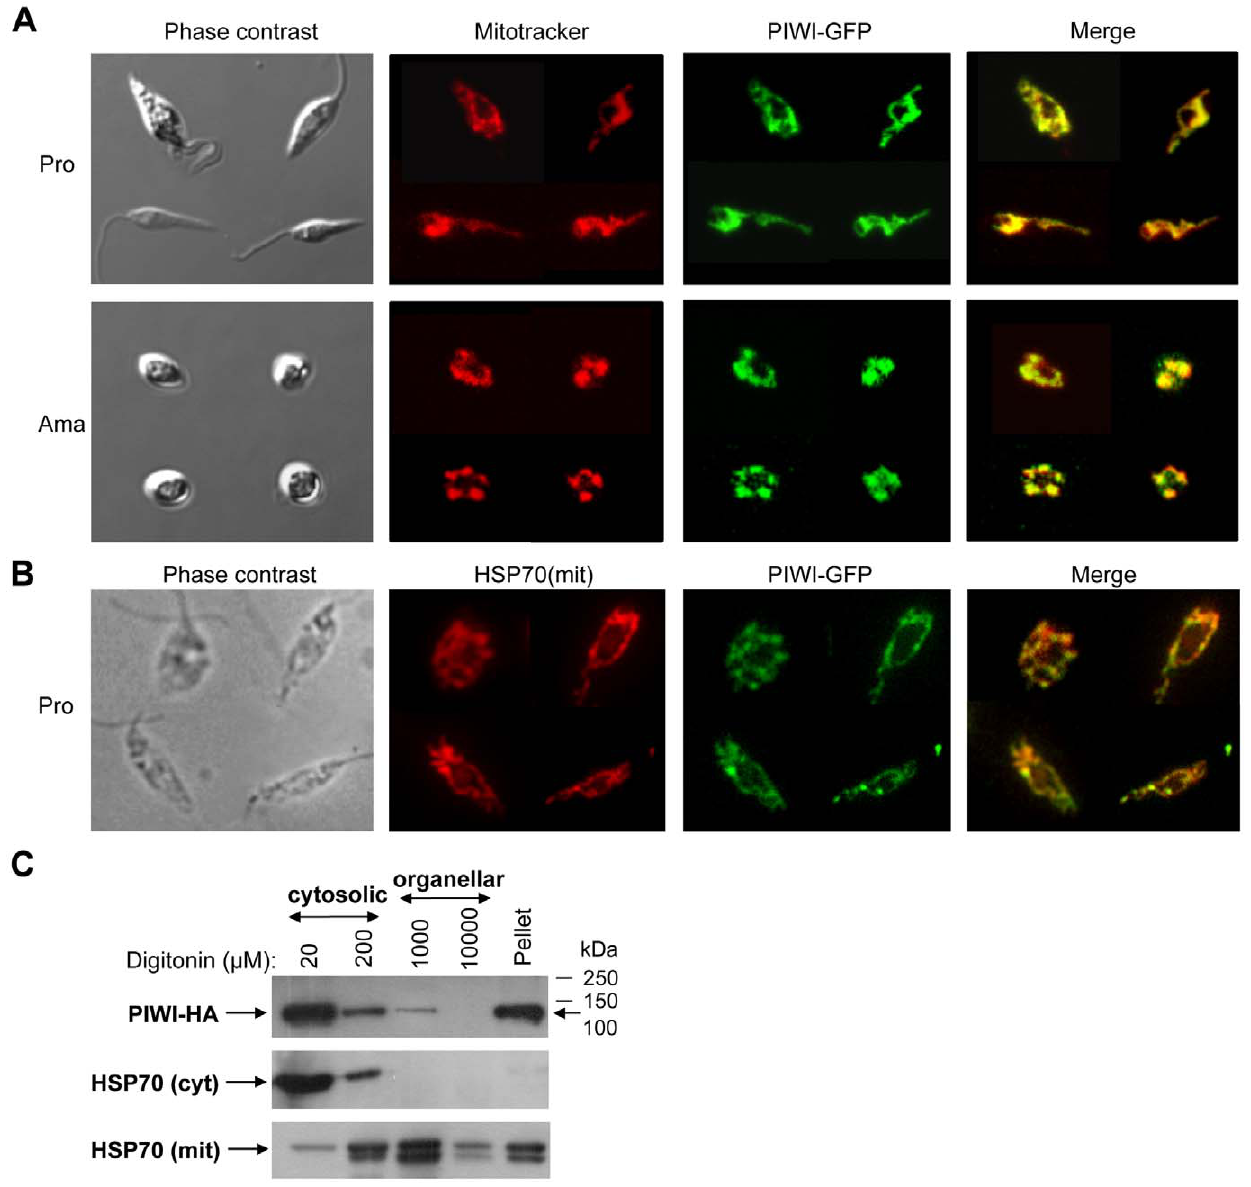
Figure 3. The Leishmania PIWI-like protein is mainly localized in the mitochondrion. (A) Localization of PIWI-GFP protein was monitored in both L. infantum promastigote (Pro) and axenic amastigote (Ama) forms by confocal microscopy. Mitotracker (a red fluorscent dye) was used to stain the Leishmania single mitochondrion. The green fluorescence signal of GFP was mostly co-localized with that of the Mitotracker. (B) Immunolocalization studies using epifluorescence microscopy to confirm mitochondrial localization of the PIWI-like protein. PIWI largely co-localizes with a known mitochondrial protein, HSP70. (C) Digitonin fractionation was carried out in L. infantum Lin HA-PIWI-HA recombinant promastigotes. Western blot of digitonin-fractionated samples (20 m M–10 mM) was probed with an anti-HA antibody to detect the PIWI protein and with anti-HSP70 (cytosolic) and anti-HSP70 (mitochondrial) antibodies used as controls for cytoplasmic and mitochondrial proteins, respectively. The 20 and 200 m M digitonin lanes correspond to cytosolic fractions and the 1 mM and 10 mM lanes correspond to organellar fractions. The pellet fraction contains membrane-associated proteins. doi:10.1371/journal.pone.0052612.g003 to complement the PIWI ( 2 / 2 ) null mutant phenotype failed as none of the episomally expressed PIWI epitope-tagged (e.g. HA, Myc, and GFP) proteins or even the original PIWI gene without any tag (Figure S5) transfected into Lmj PIWI ( 2 / 2 ) or Lin PIWI ( 2 / 2 ) mutant background could rescue efficiently for the loss of the endogenous PIWI protein (data not shown). The fact that we could only detect the PIWI-tagged proteins by western blot after enrichment or cell fractionation (Figure 3C and data not shown)